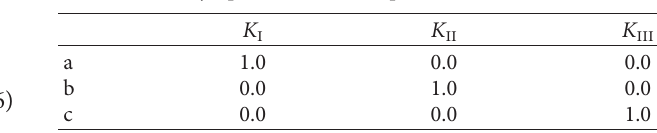
Table 1: The asymptotic solution of pure mode crack is